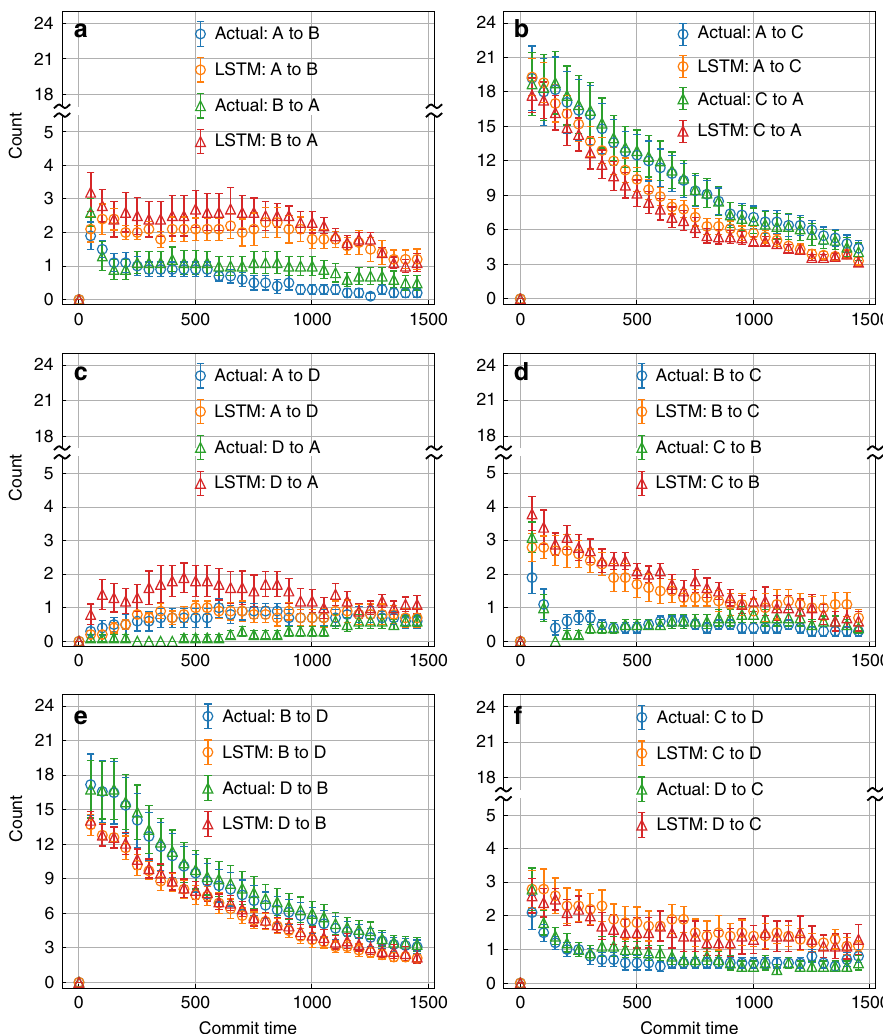
Fig. 4 Kinetics for 4-state model system. Number of transitions between different pairs of metastable states as a function of commitment time de fi ned in “ Results ” section for 4-state model system. Error bars are illustrated and were calculated as standard